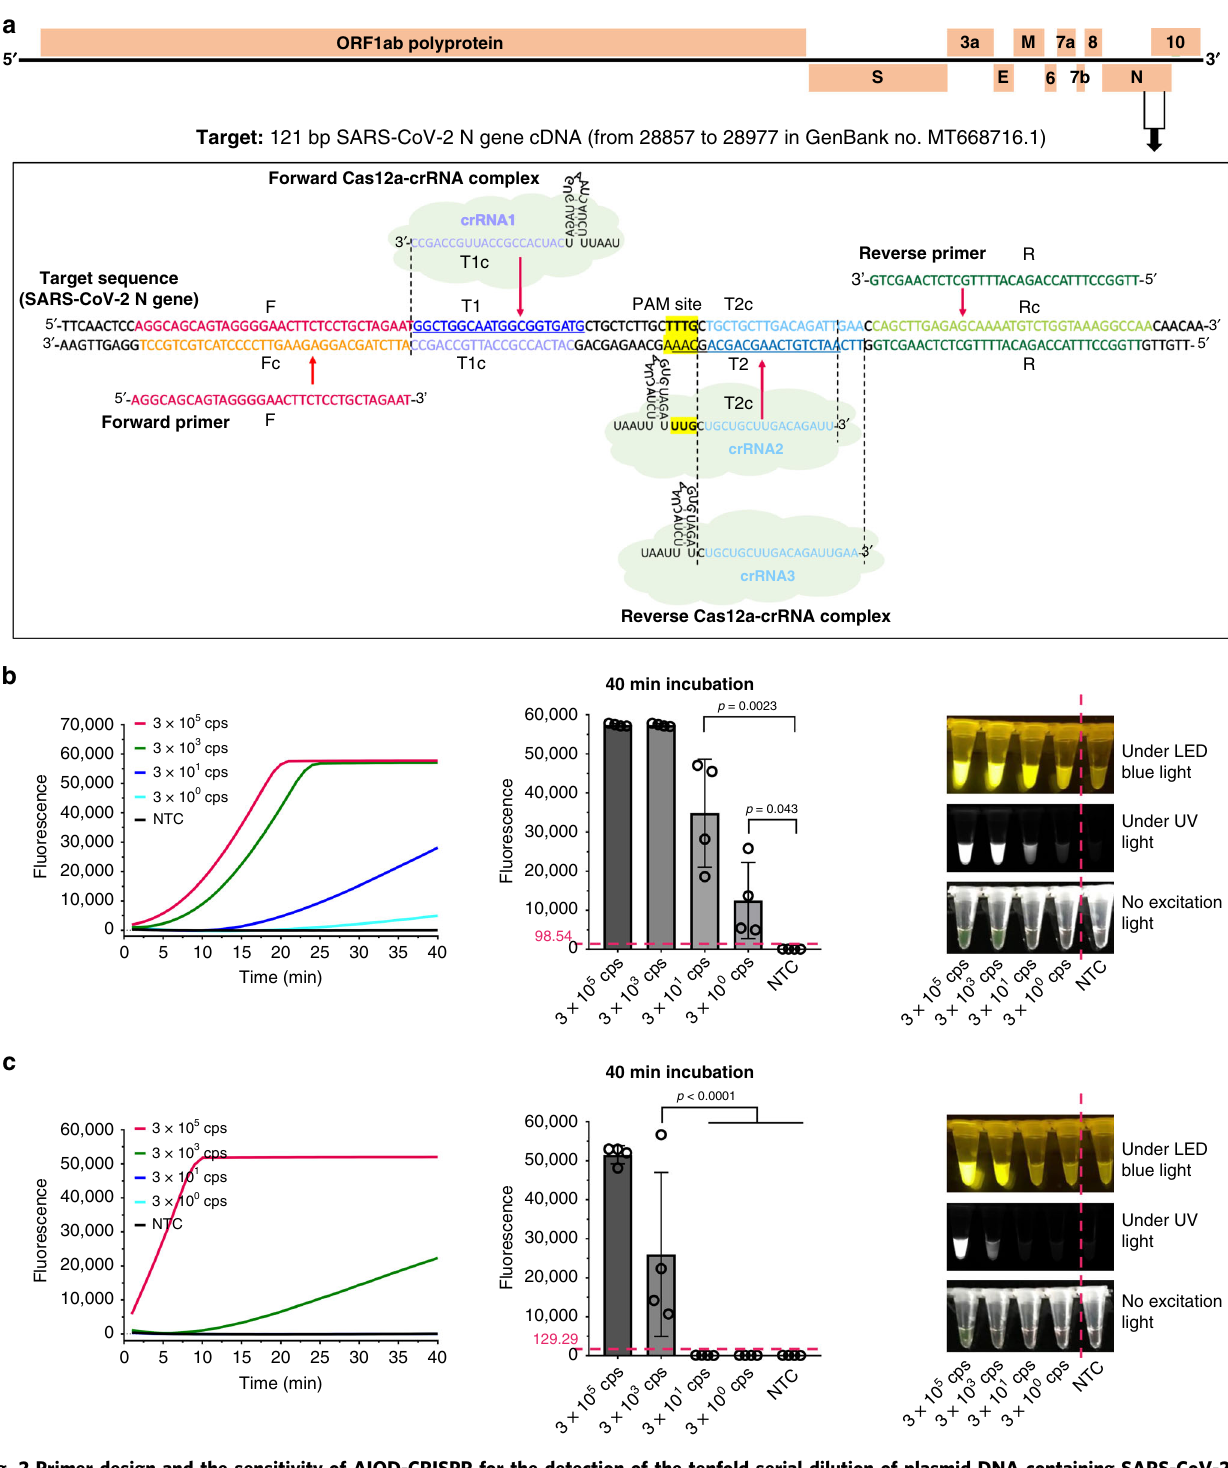
Fig. 2 Primer design and the sensitivity of AIOD-CRISPR for the detection of the tenfold serial dilution of plasmid DNA containing SARS-CoV-2 N gene sequence (N plasmid). a SARS-CoV-2 genome map with the detailed sequence information of the designed primers and crRNAs targeting the N gene sequence. For comparison purpose, the designed crRNA1 and crRNA2 were not limited by the PAM site (5 ′ -TTTG-3 ′ ), while the crRNA3 was limited by the PAM site. b Real-time/endpoint AIOD-CRISPR assay using dual crRNAs (crRNA1&2) without PAM site limitation. Source data are provided as a Source Data fi le. c Real-time/endpoint AIOD-CRISPR assay using single crRNA (crRNA3) with PAM site limitation. Four replicates were run ( n = 4). Source data are provided as a Source Data fi le. The horizontal dashed line indicates the cutoff fl uorescence that was de fi ned by the average intensity of NTC plus three times of the standard deviation. NTC, non-template control reaction. Error bars represent the means ± standard deviation (s.d.) from replicates. The unpaired two-tailed t -test was used to analyze the statistical signi fi cance. Source data is available for b , c